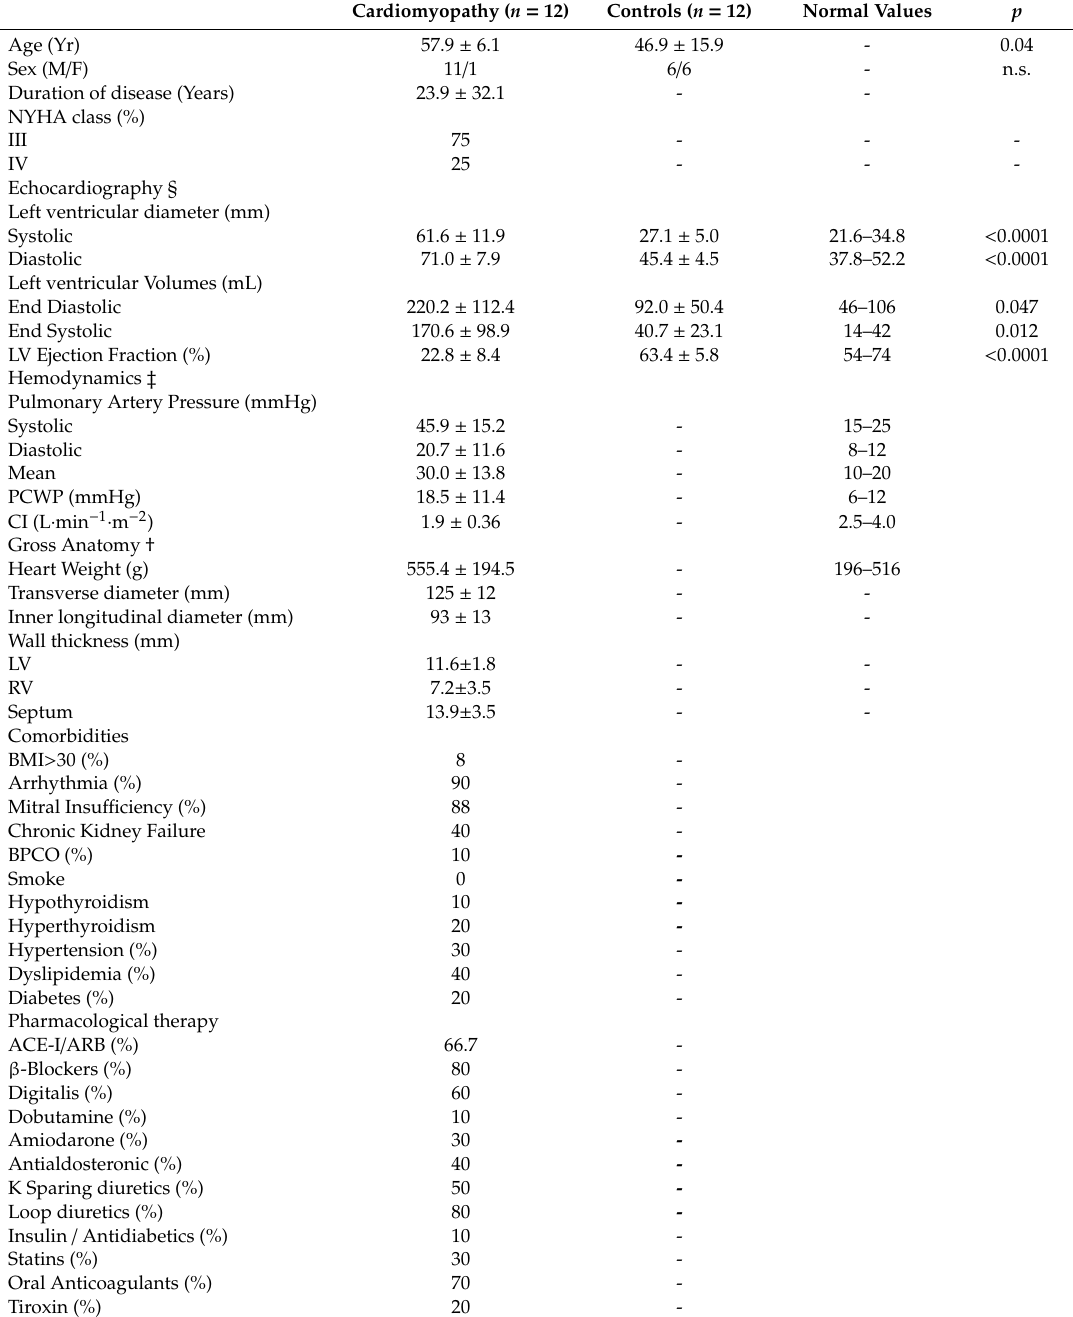
Table 2. Clinical, demographic, and anatomical parameters of the patients whose hearts were included in the metabolomic